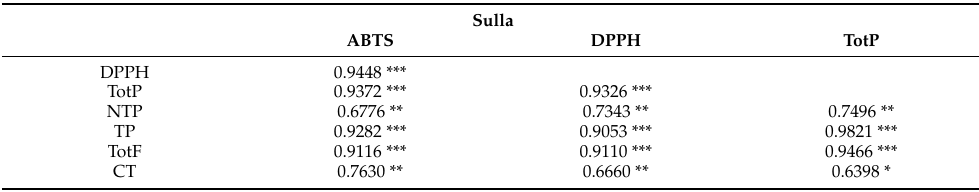
Table 5. Correlations ( R 2 ) established between total phenolics (TotP), non-tannic phenolics (NTP), tannic phenolics (TP), total flavonoids (TotF), condensed tannins and antioxidant capacity (ABTS, DPPH) in Sulla coronaria shoots.